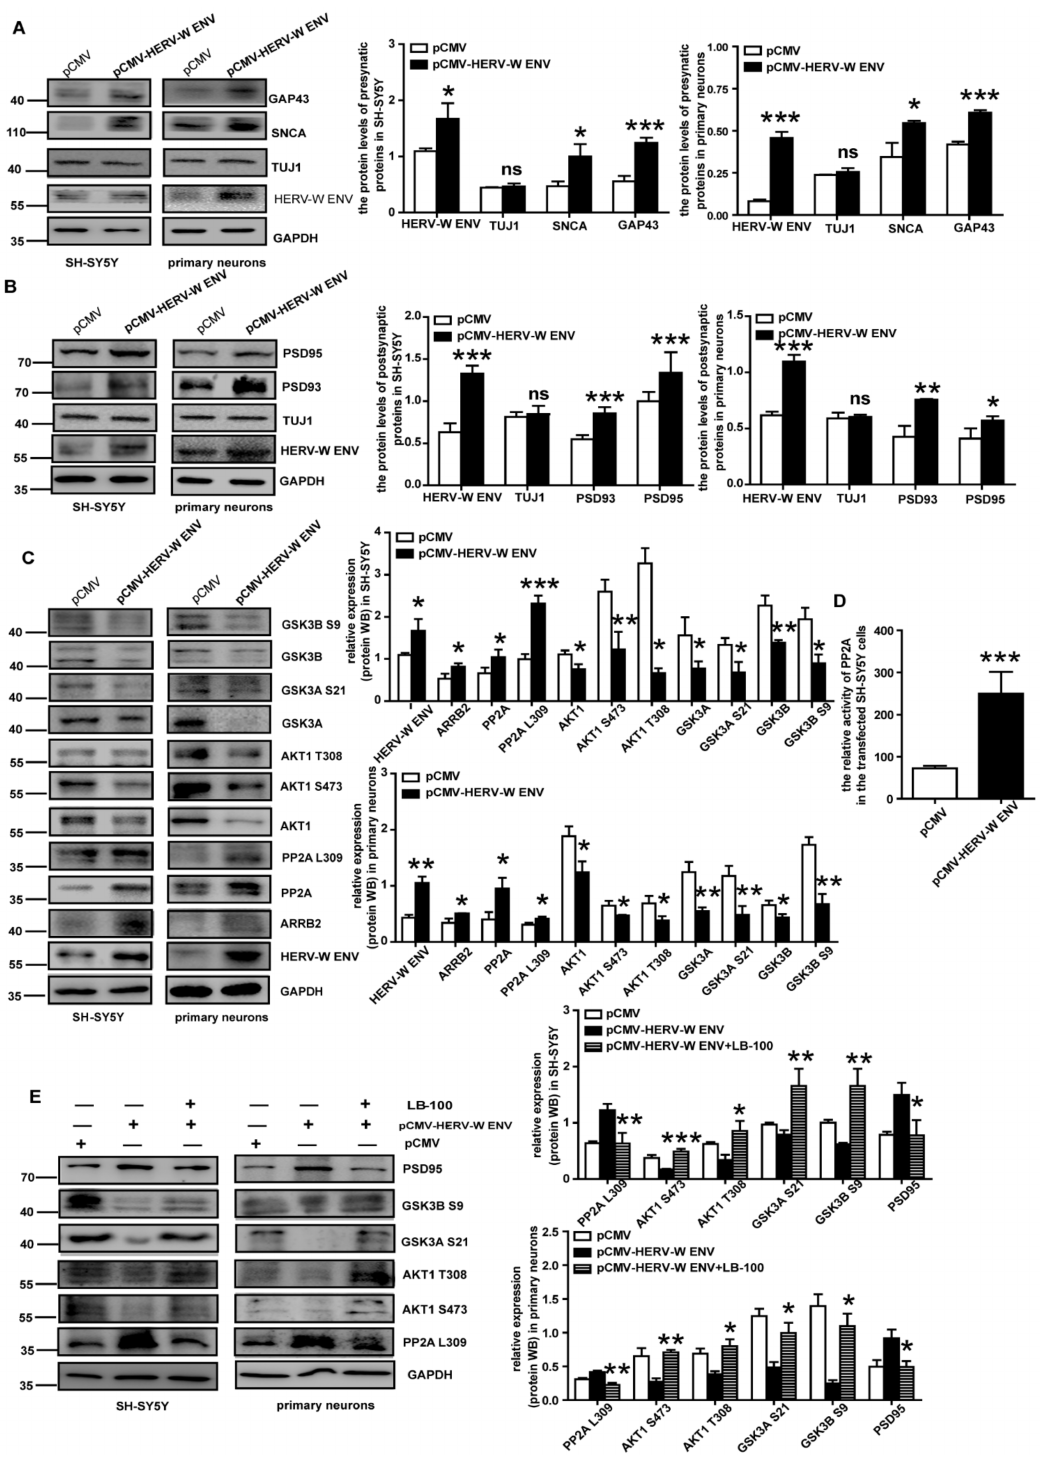
Figure 5. HERV-W ENV promotes synaptic proteins and regulates the PP2A/AKT1/GSK3 signal pathway: ( A , B ) representative Western blots for the presynaptic and postsynaptic proteins, GAPDH, and TUJ1 in the SH-SY5Y cells and the primary neurons. ( C ) Overexpression of HERV-W ENV in the DA neurons increased PP2A and AKT1 and regulated the downstream protein. ( D ) PP2A activity detected by biochemical kit assay increased in the pCMV-HERV-W ENV group in SH-SY5Y cells. ( E ) The PP2A was downregulated and its downstream proteins were upregulated after using LB-100 (inhibitor of PP2A) in the DA neurons. ns p > 0.05, * p < 0.05, ** p < 0.01, *** p <